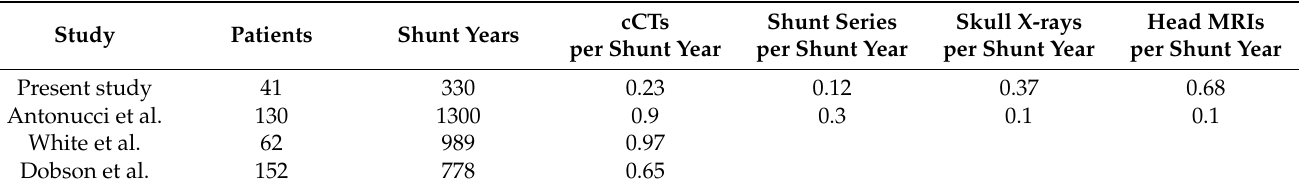
Table 2. Comparison with previous studies. Values represent the numbers of imaging procedures per shunt year published by Antonucci et al., White et al. and Dobson et al. compared to our data. White et al. and Dobson et al. only investigated CT scans; therefore, no data were available for the other diagnostic